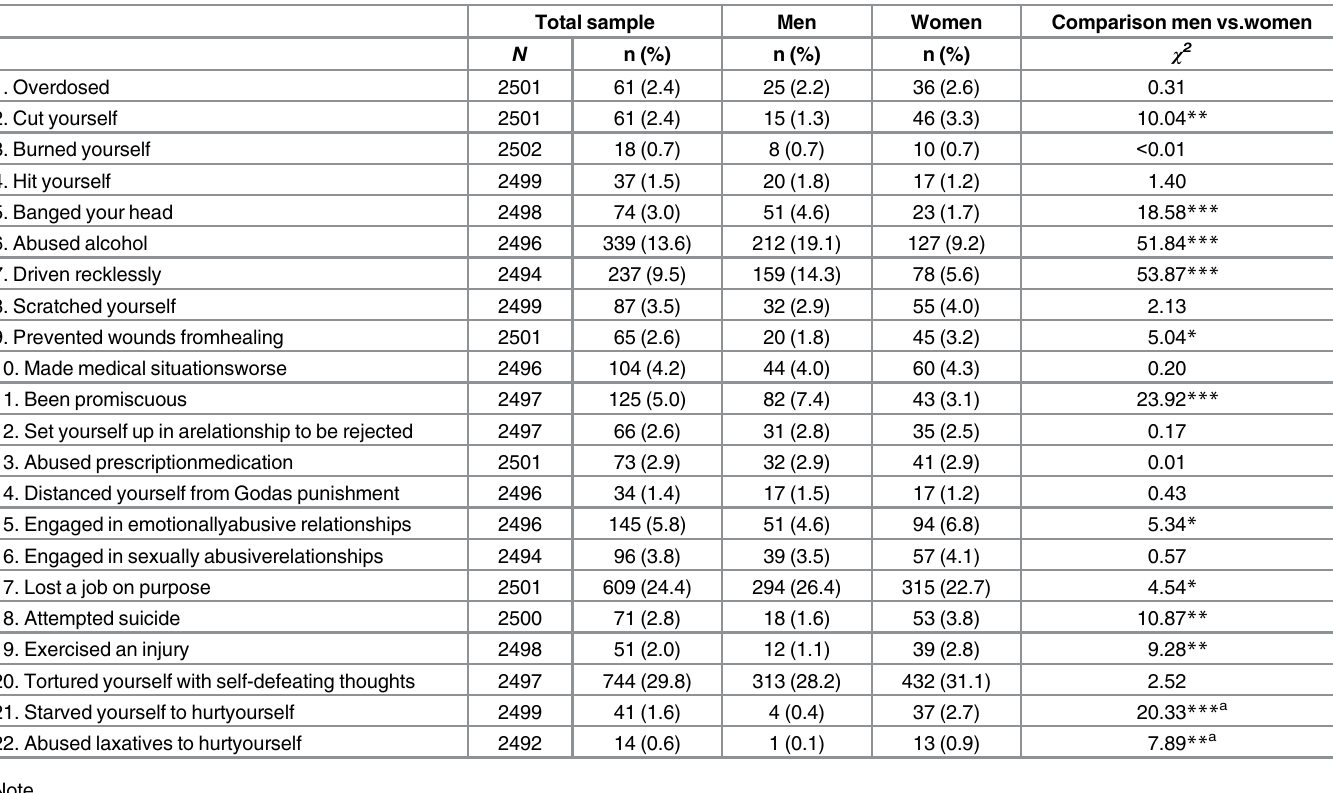
Table 5. Frequencies of self-harming behaviors for the total sample, and separately for men and